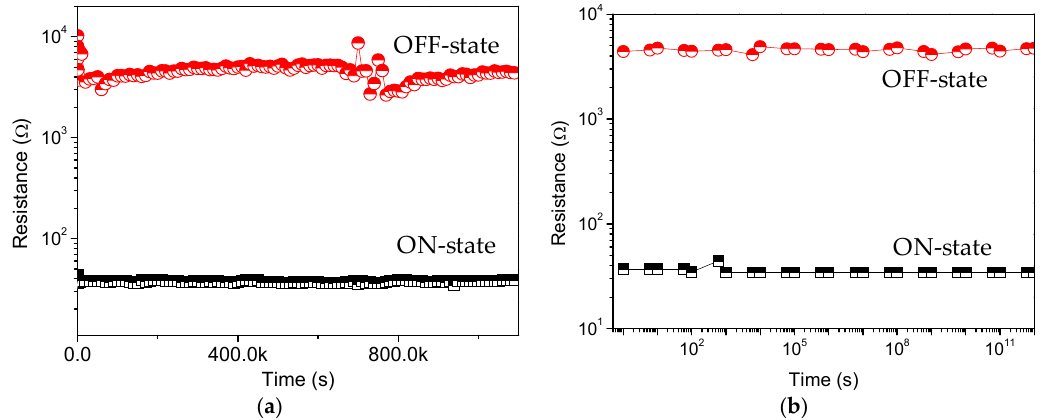
Figure 5. Retention ability of the PBD:GO memory with 10:1 (w/w) at a ( a ) constant and ( b ) pulse of reading voltage 0.1 V.